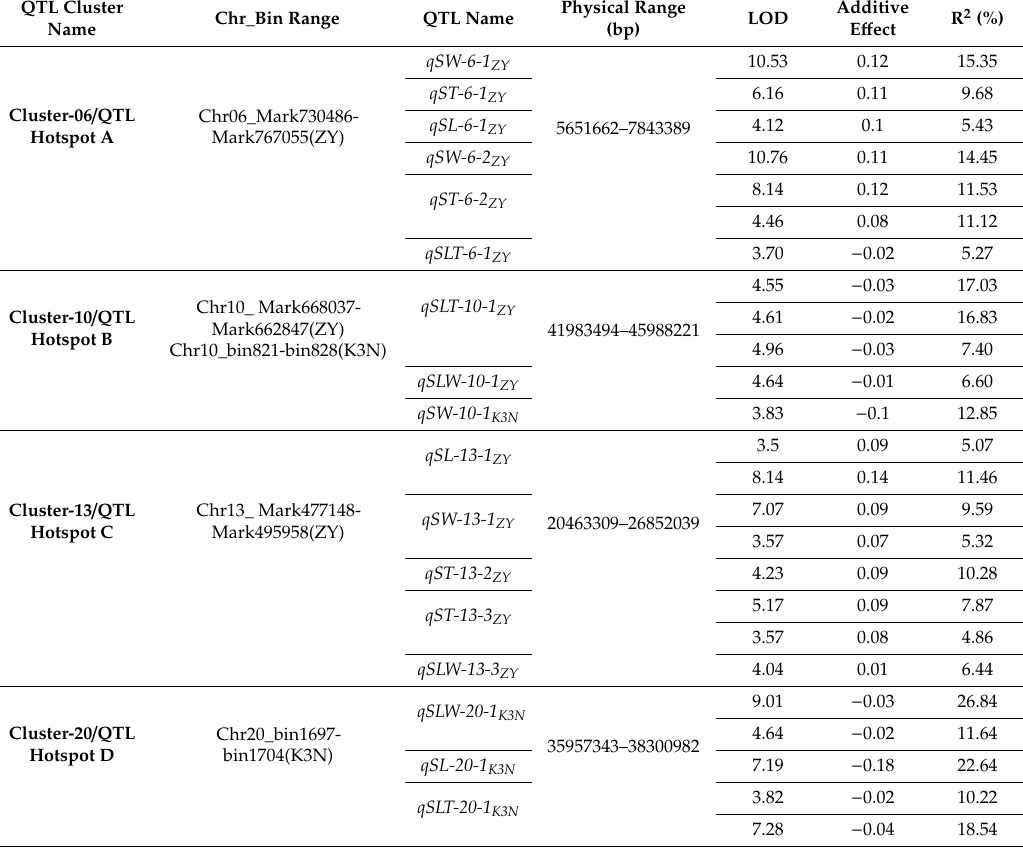
Table 5. Four QTL hotspots / clusters detected in ZY and K3N RIL populations across multiple